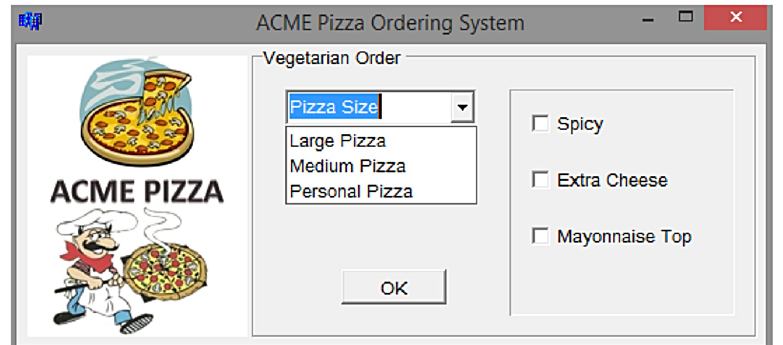
Fig 1. Acme vegetarian pizza order